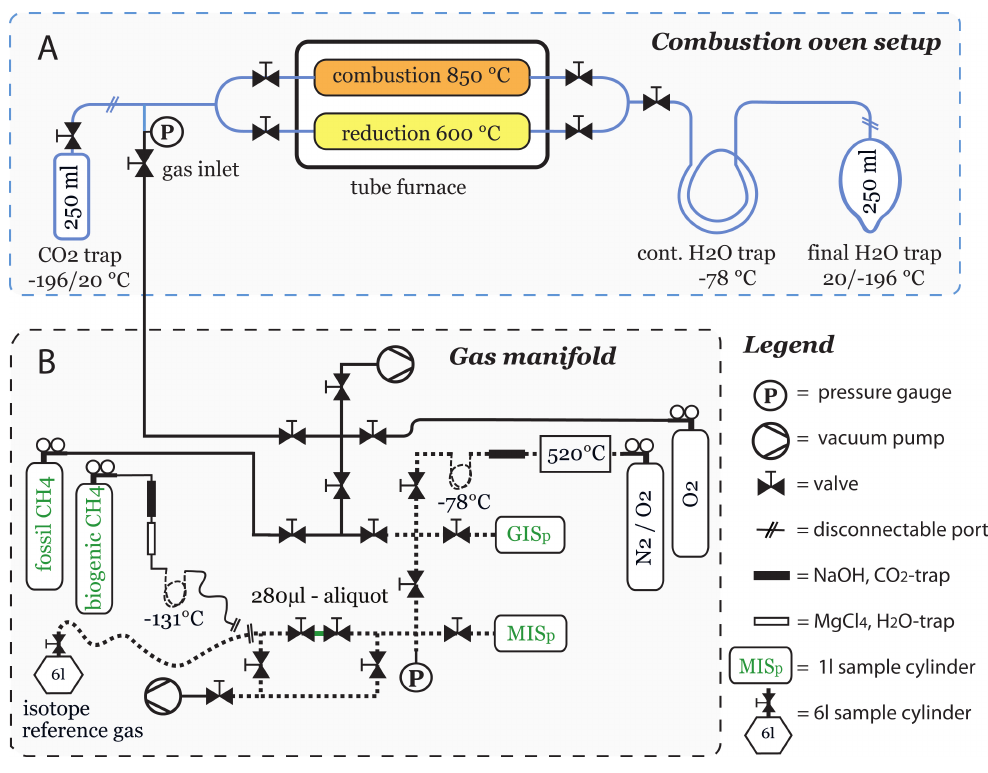
Fig. 3. Schematic figure of the setup. The top panel (A) illustrates the combustion and reduction reactors as well as the CO 2 and the two H 2 O traps. The blue lines indicate the glass parts of this vacuum component. The diagonal parallel lines indicate the disconnection ports, where the CO 2 trap and the H 2 O trap can be removed to transfer the sample. The bottom panel (B) shows the gas manifold that facilitates mixing and aliquoting the samples. Solid black lines represent the brass components used for gas introduction and evacuation. Dotted black lines indicate stainless steel components that take pressures of up to 60 bars. Diagonal parallel lines show the disconnection port that either connects the tank of biogenic CH 4 or the reservoir for the isotope reference gas. The aliquot volume of 280µl is indicated by the green line between the valves